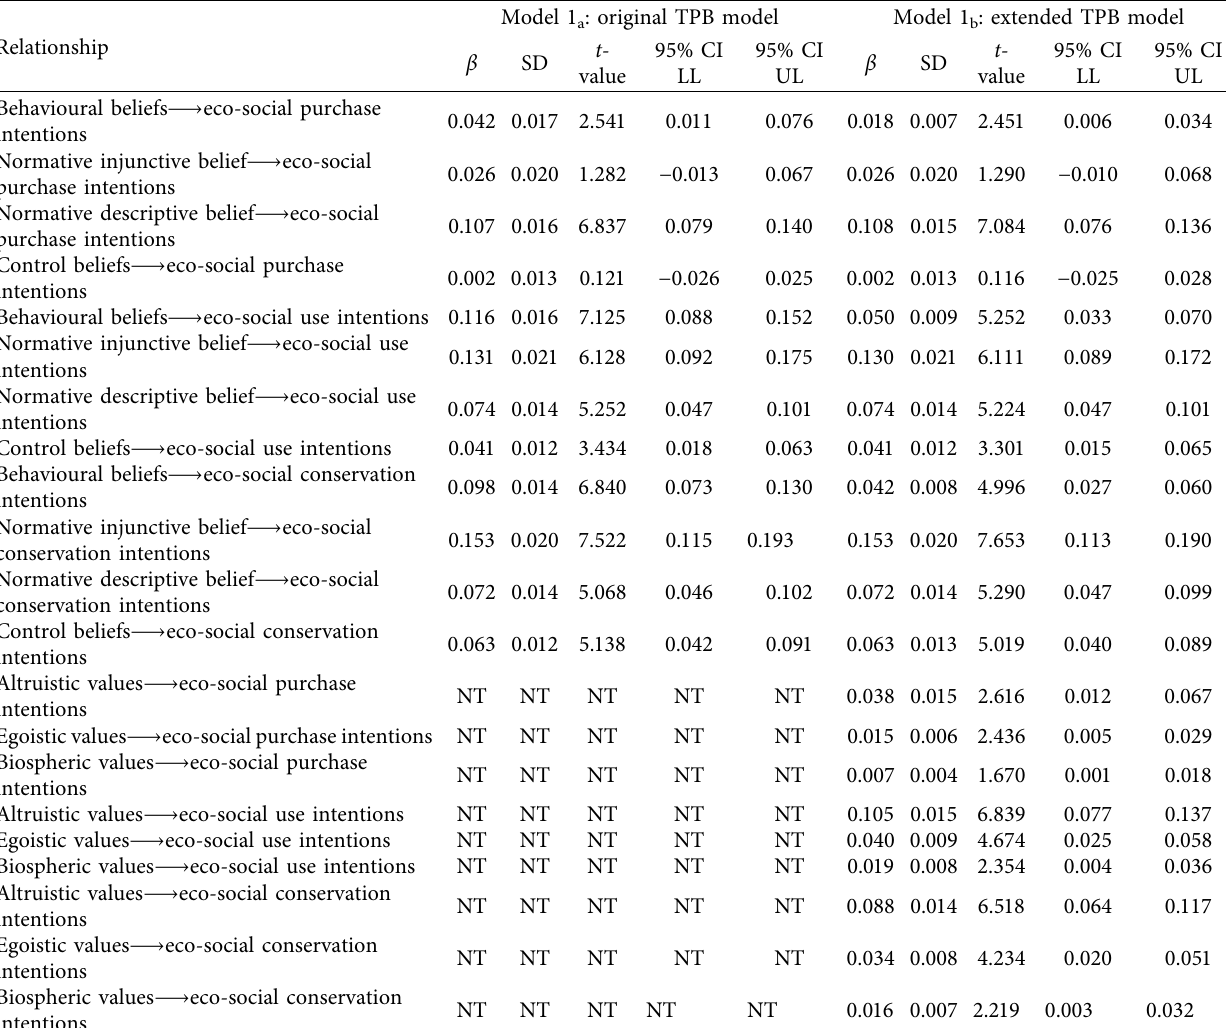
Table 8: Estimates of total indirect